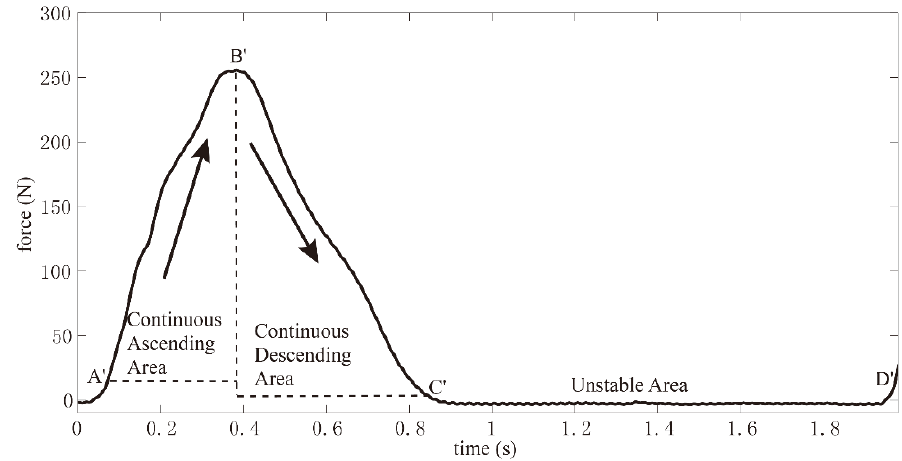
Figure 3. Sliding window detector divides the GCF into three parts.